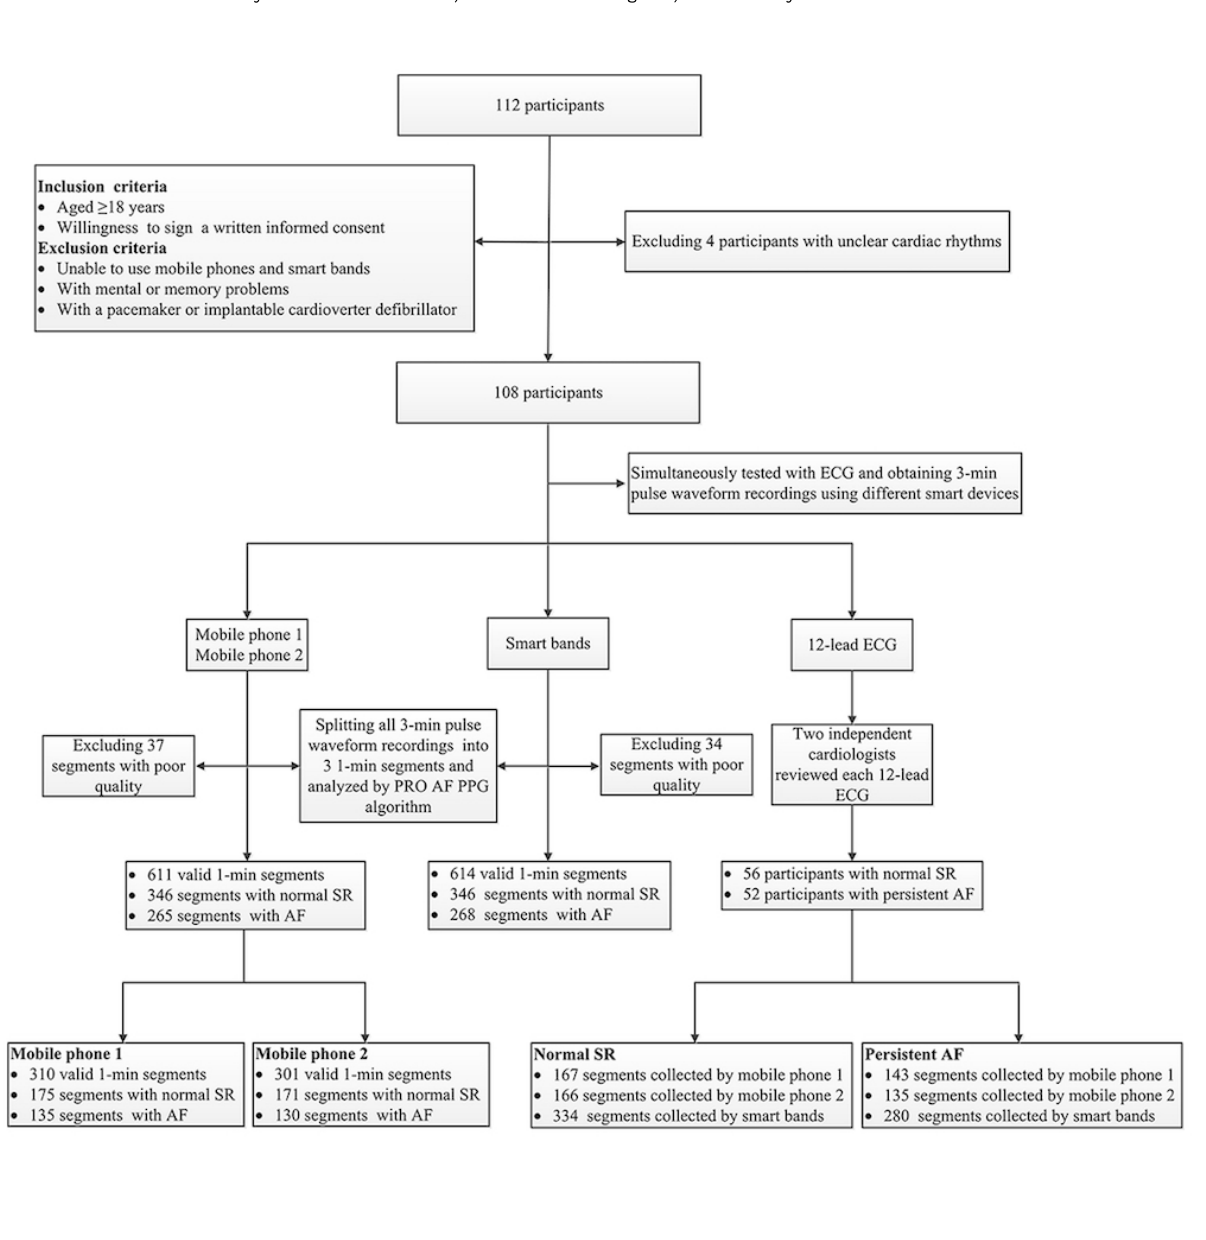
Figure 2. A flowchart of the study. AF: atrial fibrillation; ECG: electrocardiogram; SR: sinus